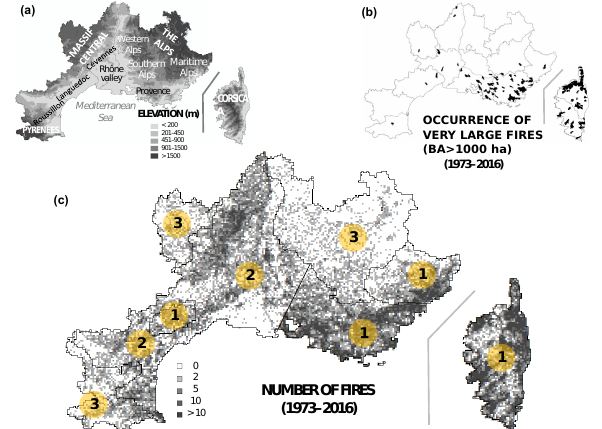
Figure 1. Maps of the study area. (a) Geographical map. (b) Occur- rence of very large fires (BA > 1000ha.). (c) Density of the number of fires on a 2 × 2km grid and location of the three pyroclimatic regions (numbered circles in yellow).